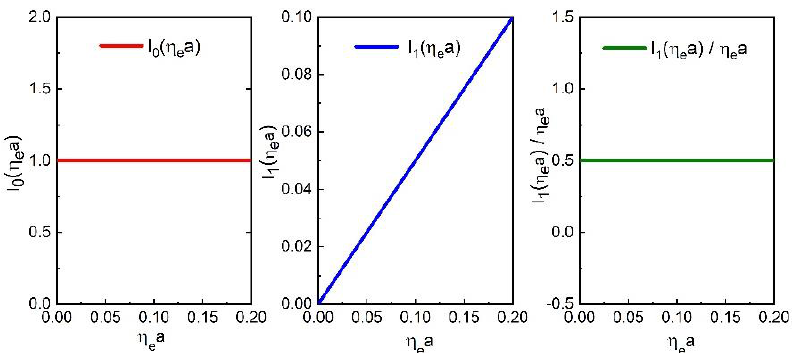
Figure 5. Diagram of the first kind modified Bessel function values. The left one is the first-kind zero-th order modified Bessel function 𝐼 0 (𝜂 𝑒 𝑎) , the middle one is the first-kind first-order modified Bessel function 𝐼 1 (𝜂 𝑒 𝑎) , and the right one is the ratio of 𝐼 1 (𝜂 𝑒 𝑎) to the independent variable.